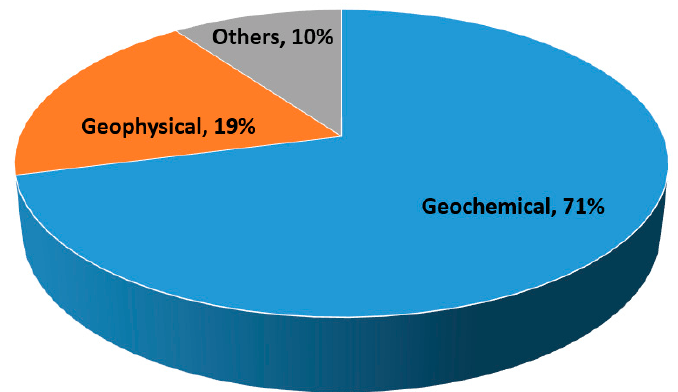
Figure 1. Geochemical methods have played an important role in the discoveries of 817 new mineral deposits in China during the period 1981–2000, modified from